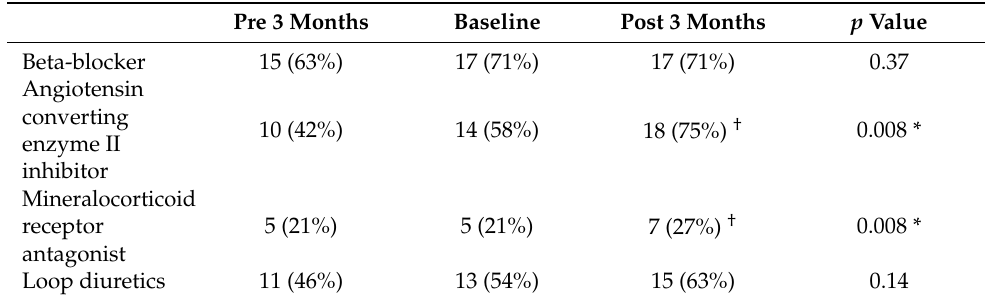
Table 2. Trend in the rate of medication